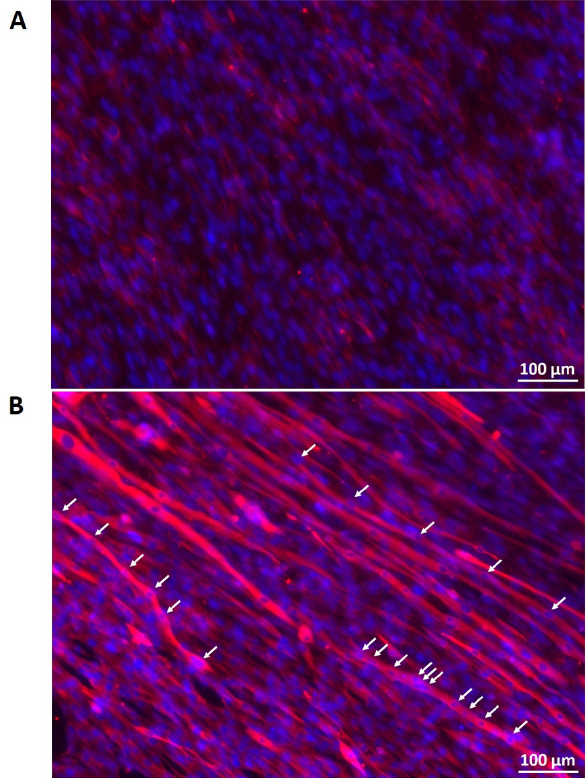
Figure 10. Myogenic differentiation and cell configuration after 28 days of myogenic differentiation of Mb/ADSC ( A ) and Mb/ADSC/SC ( B ) on PCL-collagen I-nanofibers. Fluorescence microcopy shows MHC positive (red) cells with clear evidence of highly aligned multinucleated (DAPI = blue) cells as possible myotube formation (white arrows point to nuclei in myotubes) in Mb/ADSC/SC. Scale bar 100 µm.